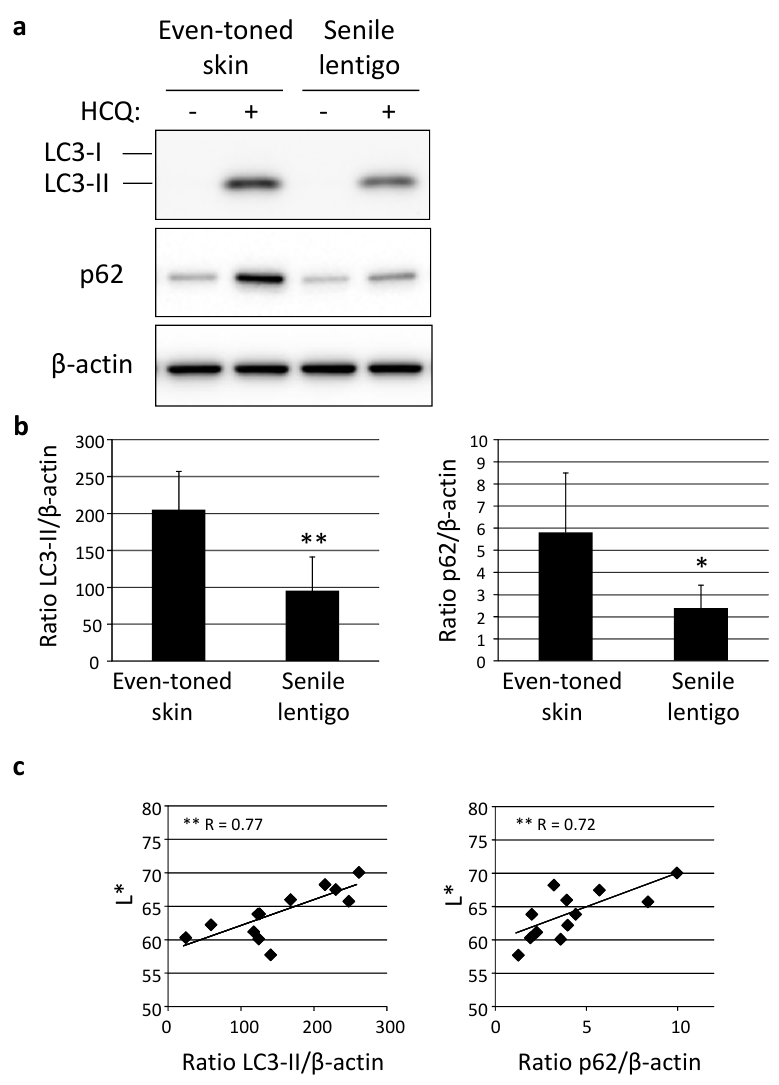
Figure 3. Decreased autophagy activity in senile lentigo. ( a ) Skin tissues obtained from even-toned and senile lentigo skin regions of Caucasian female subjects were cultured with or without 10 µ M HCQ for 48 h, followed by western-blotting analysis using LC3- or p62-specific antibodies. β -actin = loading control. ( b ) After normalization with β -actin, the ratios of LC3-II (left panel) and p62 (right panel) under both conditions in the presence and absence of HCQ were compared. Values are shown as the mean ± SD from six independent subjects. ** p < 0.01; * p < 0.05 (paired t-test). ( c ) Correlations between ratios of LC3-II (left) and p62 (right), and chromameter-retrieved L* values. ** p < 0.01 (regression analysis).